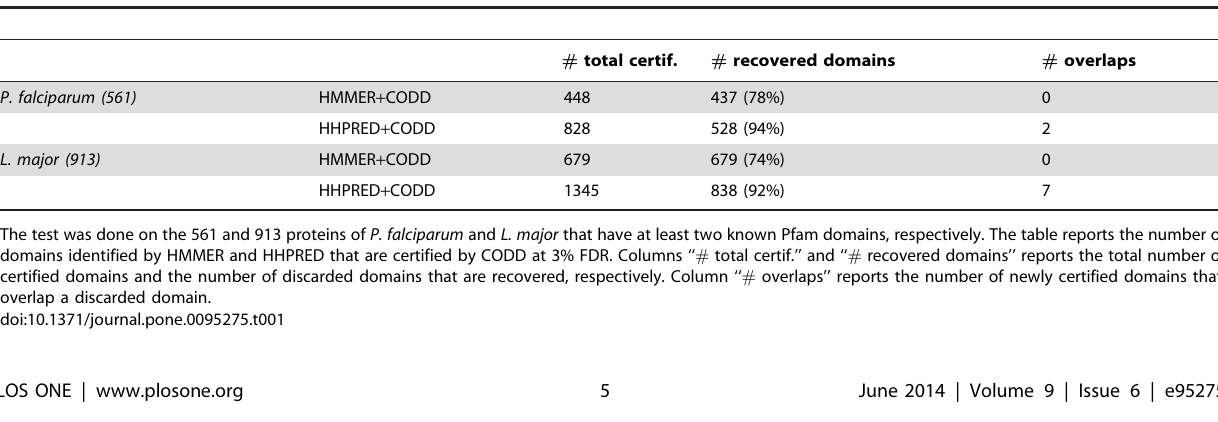
Table 1. Cross-validation experiments on P. falciparum and L. major